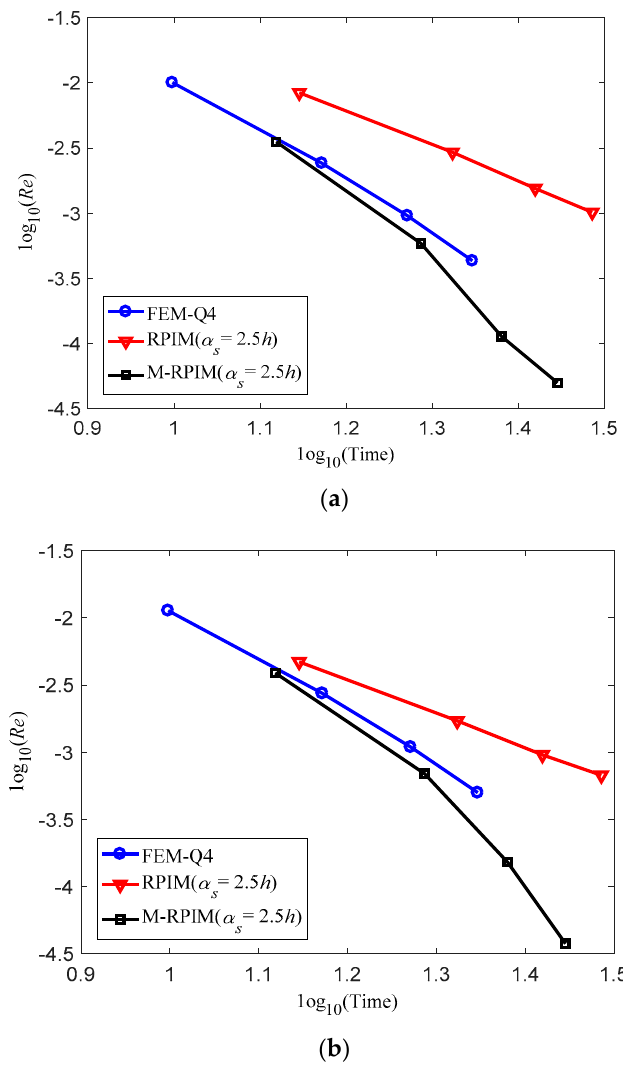
Figure 6. Comparison of the relative error results (Re) of the natural frequency values versus the computation cost for the three different numerical methods: ( a ) Mode 1; ( b ) Mode 2.